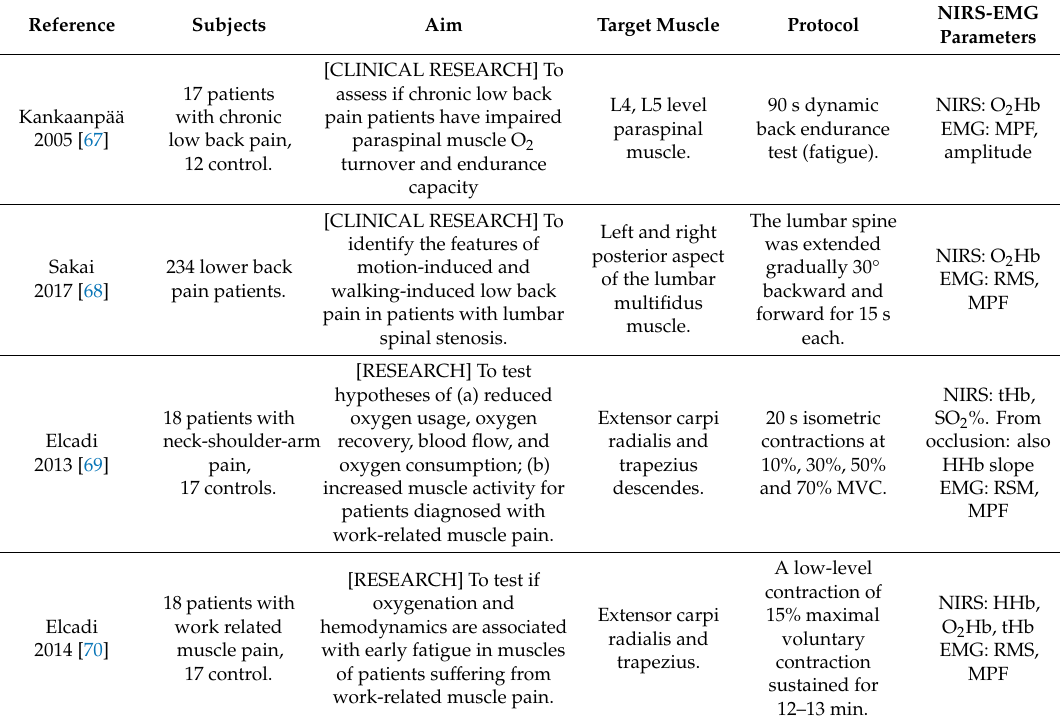
Table 1. List of the works founds for the “NIRS and EMG”